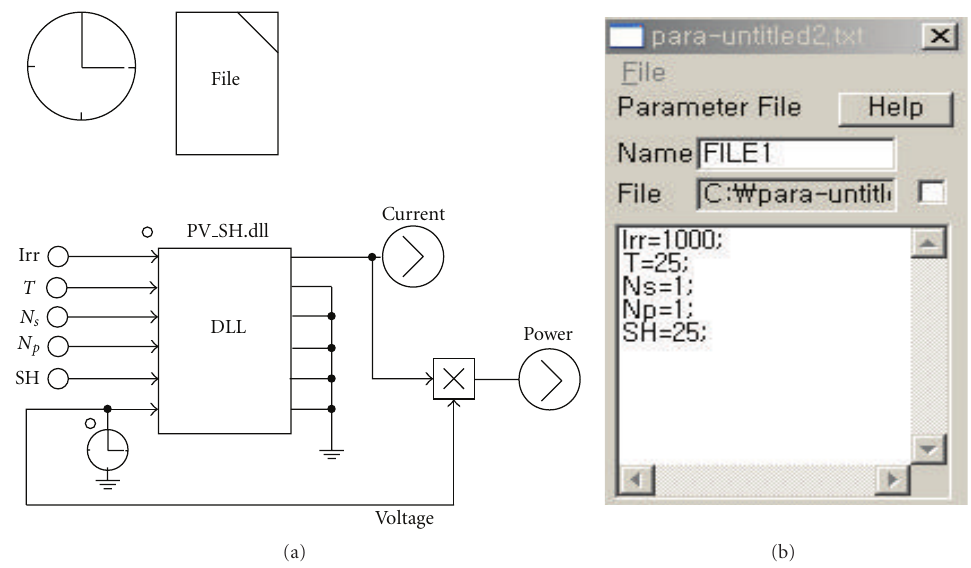
Figure 4: (a) The SP model with DLL block. (b) The window for conditions input.